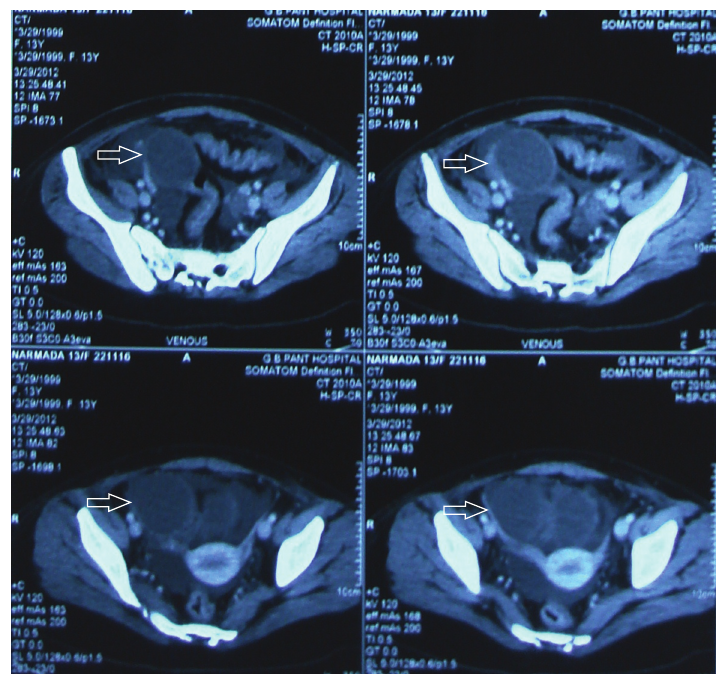
Figure 2: CT sections showing a hemorrhagic ovarian cyst.